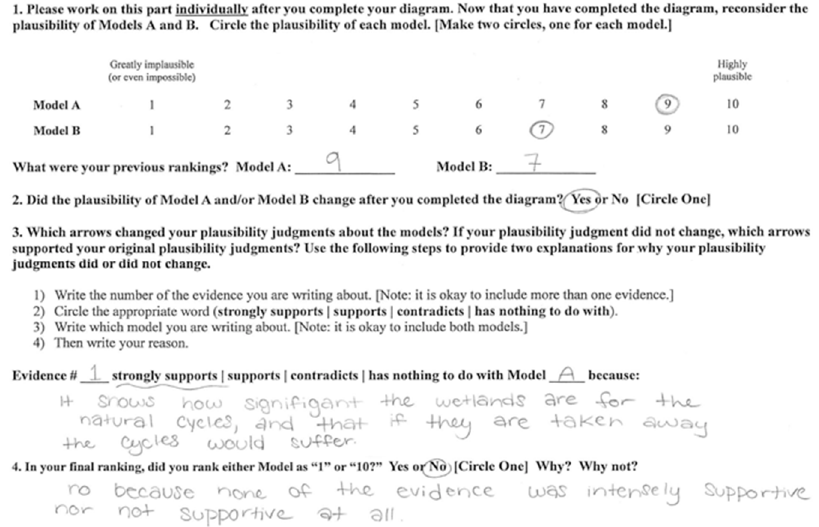
Figure 2. Plausibility Ratings and Explanation Tasks for pcMEL. A similar form was used for baMEL.